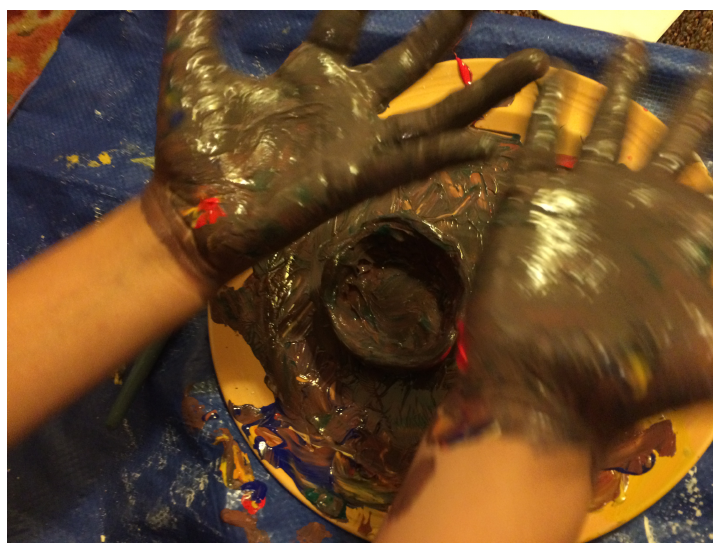
Figure 4Figure 4. Observing and reflecting/The mess as identity. Tempera paints, clay.